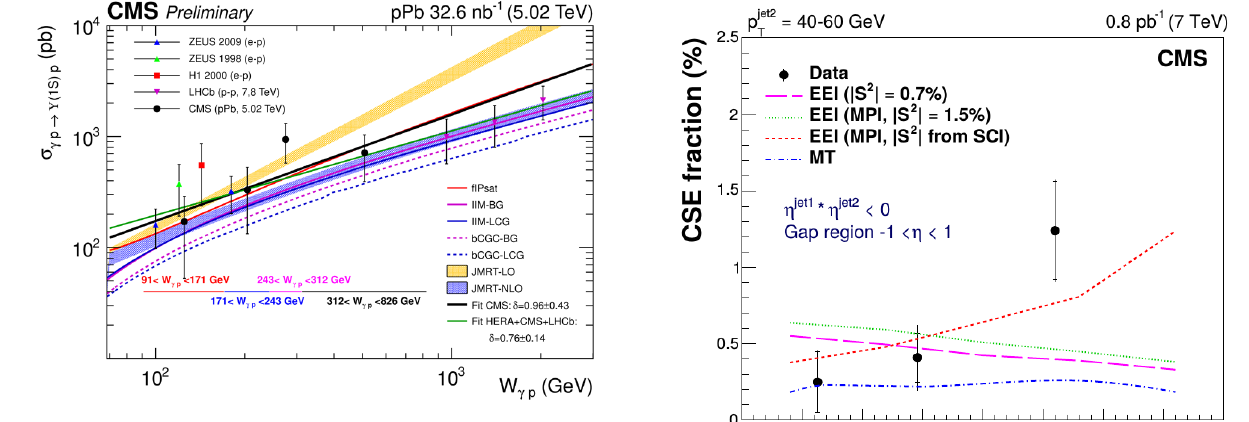
Figure 1. Measurement of the photon-proton cross section as function of photon energy (from Ref. [2]). This result is part of the exclusive Υ measurement by CMS in proton-lead collisions at √ s NN = 5 . 02TeV.